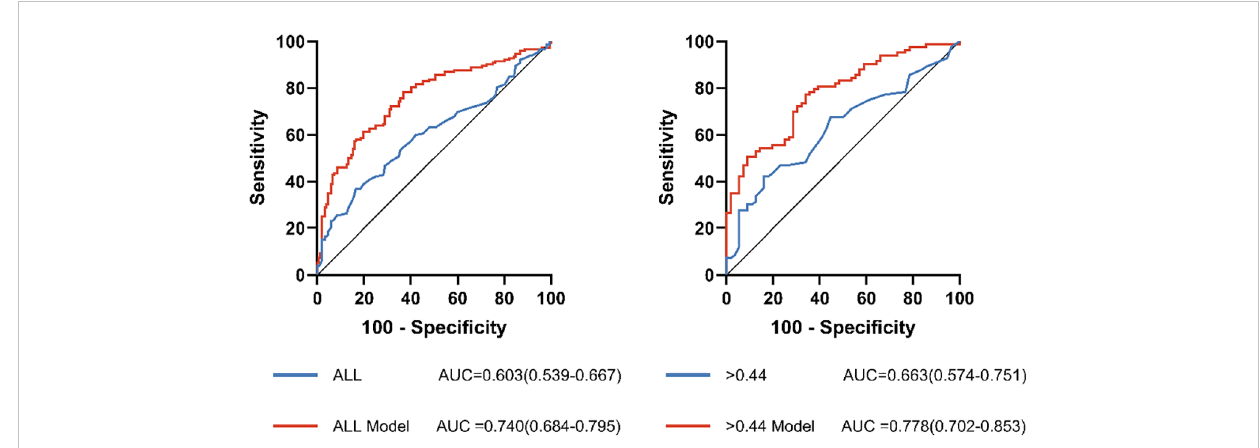
FIGURE 5 Receiver operating characteristic (ROC) curve analysis of the predictive power of MHR for AF. ALL Model, >0.44 Model: The new model integrates risk factors for AF (sex, age, BMI, hypertension, diabetes mellitus, Coronary heart disease and smoking